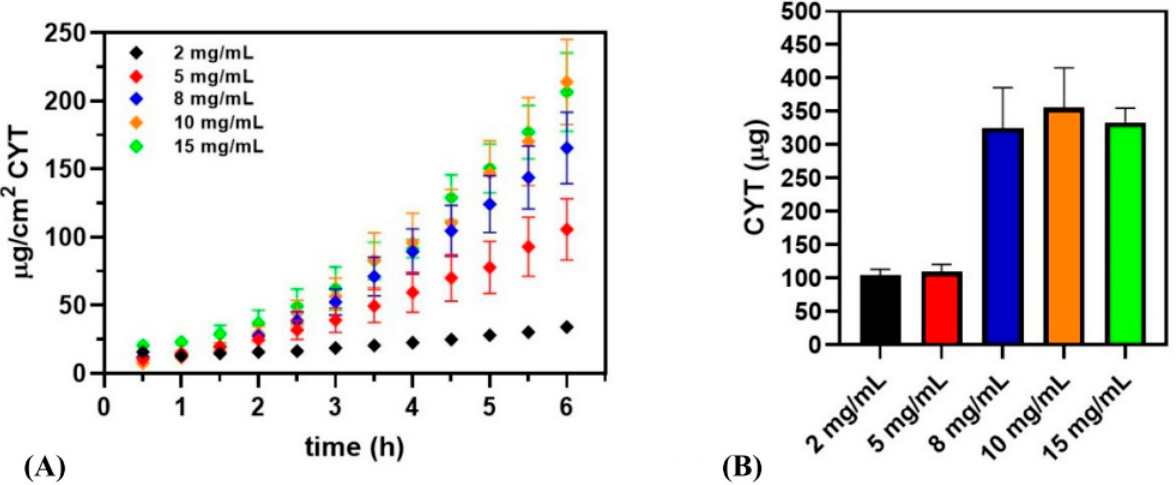
Figure 2. Permeation/penetration results by administering solutions at the following concentrations: 2 mg/mL (black), 5 mg/mL (red), 8 mg/mL (blue), 10 mg/mL (orange) and 15 mg/mL (green). ( A ) CYT ( µ g/cm 2 ) permeated as a function of incubation time (h) and ( B ) CYT ( µ g) accumulated into the buccal membrane after 6 h of the experiment. Data are presented as mean ± SE (n = 6).